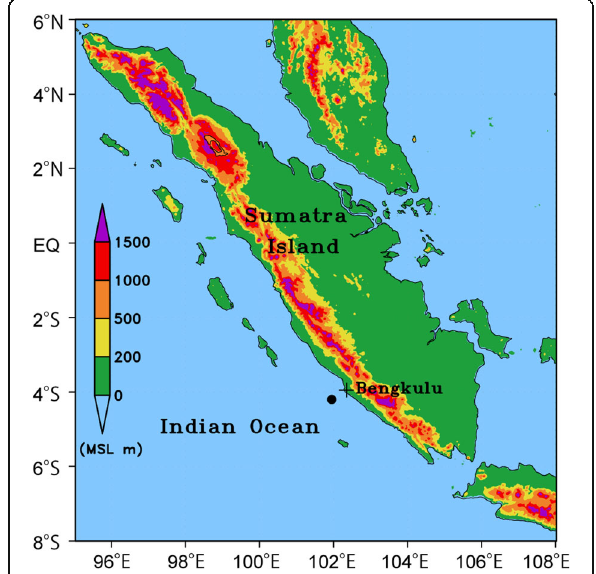
Fig. 1 Topography of Sumatra Island and its surroundings and the locations of Bengkulu Meteorological Observatory (cross) and the research vessel Mirai (closed circle). Shading denotes terrain elevation. MSL is meters above sea